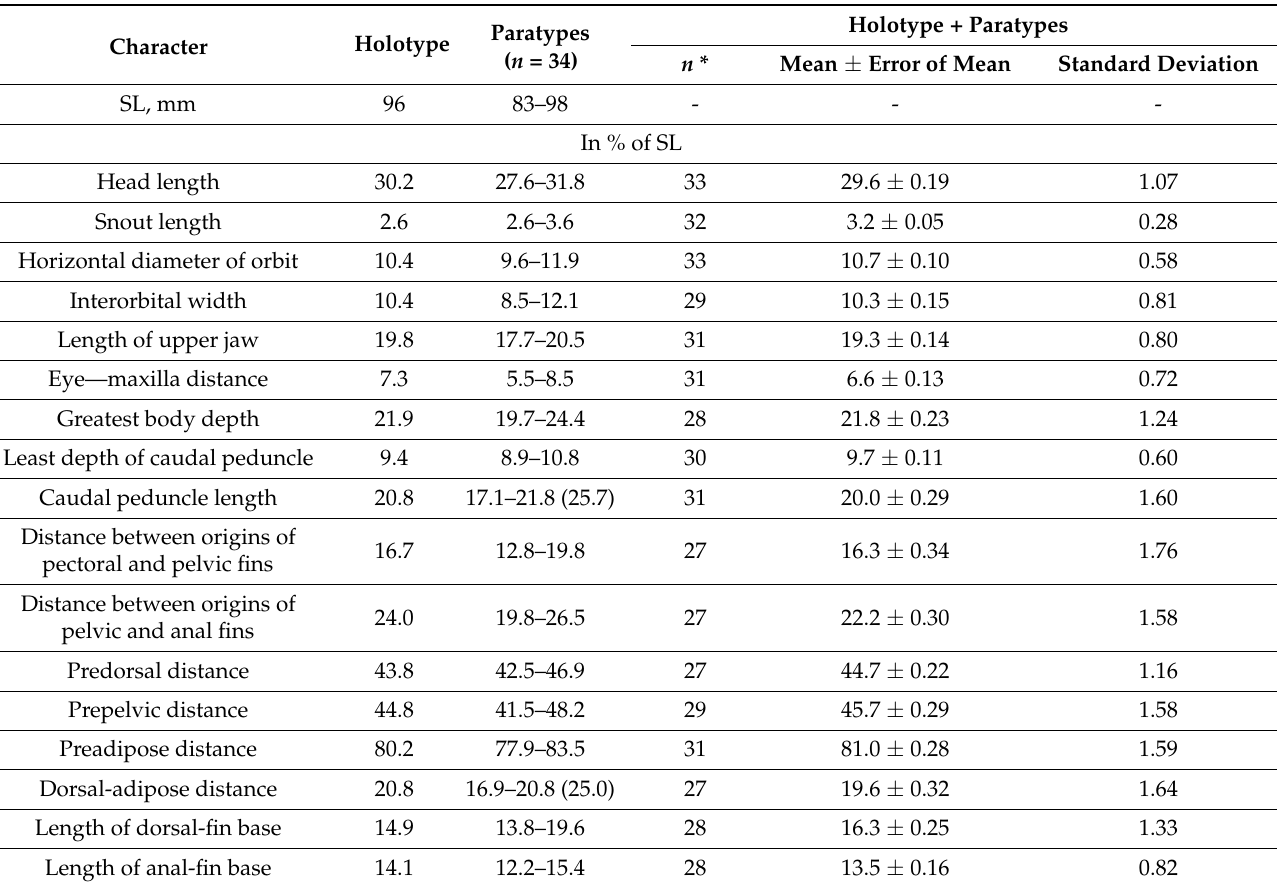
Table 2. Morphometric characters of Diaphus balanovi sp. nov. ( n = number of specimens; *—some measurements were taken from fewer than 35 specimens due to their damage in